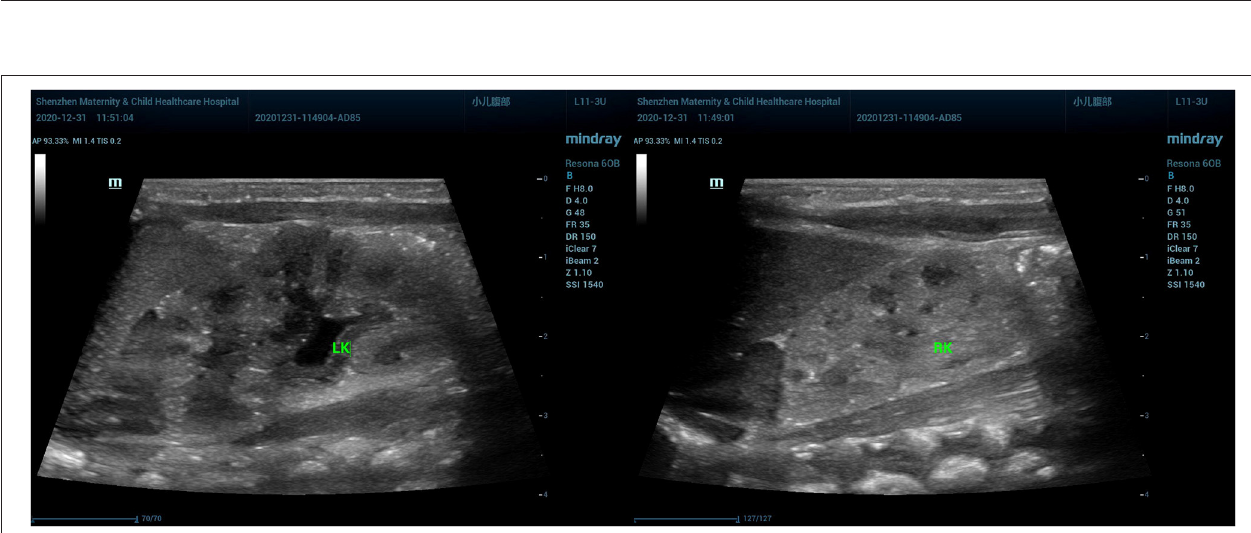
Frontiers in Pediatrics | www.frontiersin.org